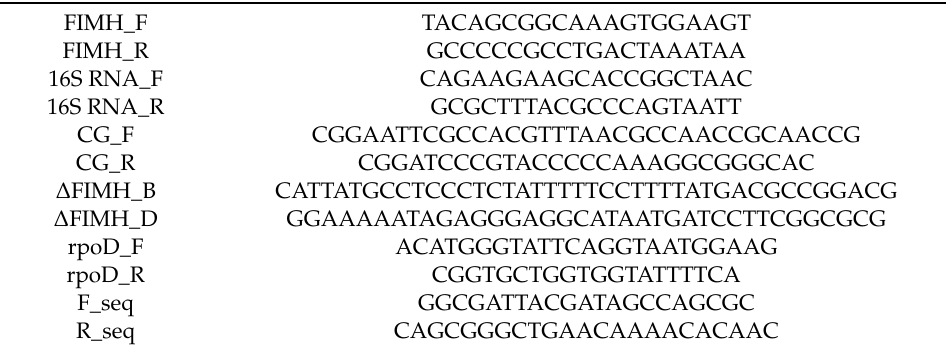
Table 3. Primers used for quantitative real-time PCR (qPCR) and for mutant